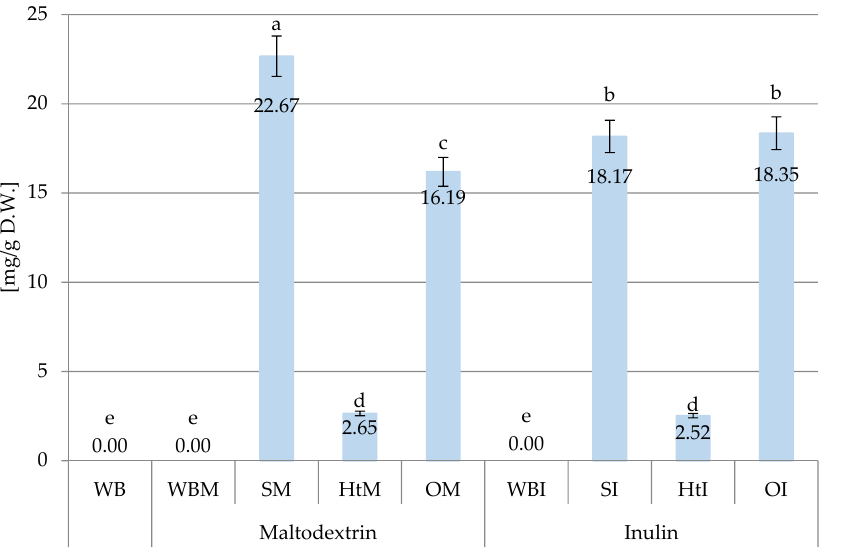
Figure 3. Sum o polyphenolic compounds of different samples of wheat bread. Abbreviations: WB— wheat bread; WBM—wheat bread with maltodextrin; SM—wheat bread enriched with soy extracts in maltodextrin; HtM—wheat bread enriched with hawthorn extracts in maltodextrin; OM—wheat bread enriched with onion husk extracts in maltodextrin; WBI—wheat bread with inulin; SI—wheat bread enriched with soy extracts in inulin; HtI—wheat bread enriched with hawthorn extracts in inulin; OI—wheat bread enriched with onion husk extracts in inulin. Values with different letters were significantly different at p = 0.05 according to Duncan’s test. The data are expressed as mean ( n =